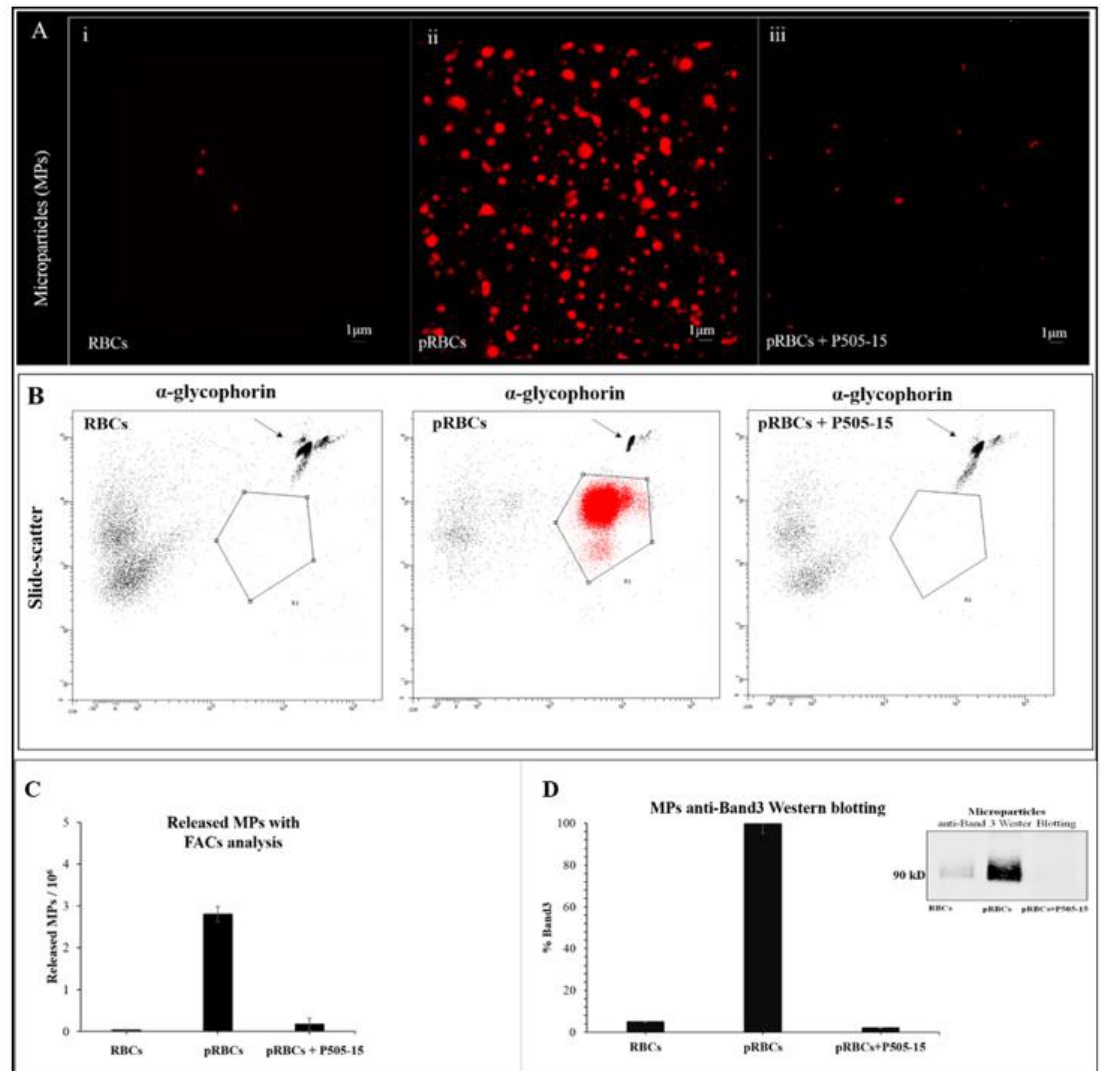
Figure 2. ( A ) Confocal Images of isolated microparticles (MPs) contained in pRBCs untreated and treated for 12 h with P505-15 (0.5 µM). MPs were visualized by their autofluorescence at 488 nm (excitation)/630–750 nm (emission). Images were acquired using the same magnification with a Leica TCS SP5 X (Leica Microsystems, Wetzlar, Germany) confocal microscope equipped with a 60 × 1.4 numerical aperture oil immersion lens. The scale bar in the figure is 1 µm. ( B ) Representative flow cytometric density plot of MPs in supernatant collected from RBCs, pRBCs, and P505-15-treated pRBCs. MPs were identified as glycophorin A-positive events (R1). The number of MPs was quantified using the known density of fluorescent trucount TM beads (arrows). ( C ) Graphical representation of flow cytometric density plot of MPs. ( D ) MP anti-band 3 Western blotting.